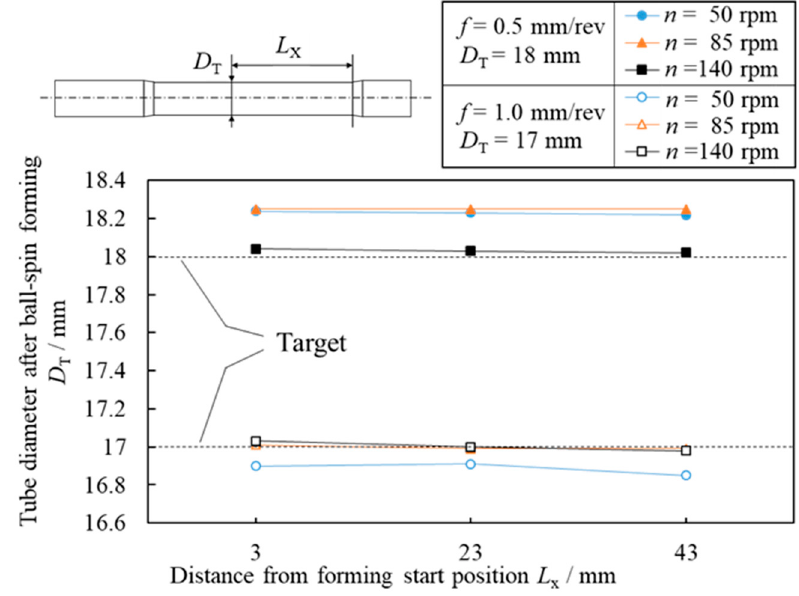
Figure 6. Distribution of the outer diameter of the formed tubes.